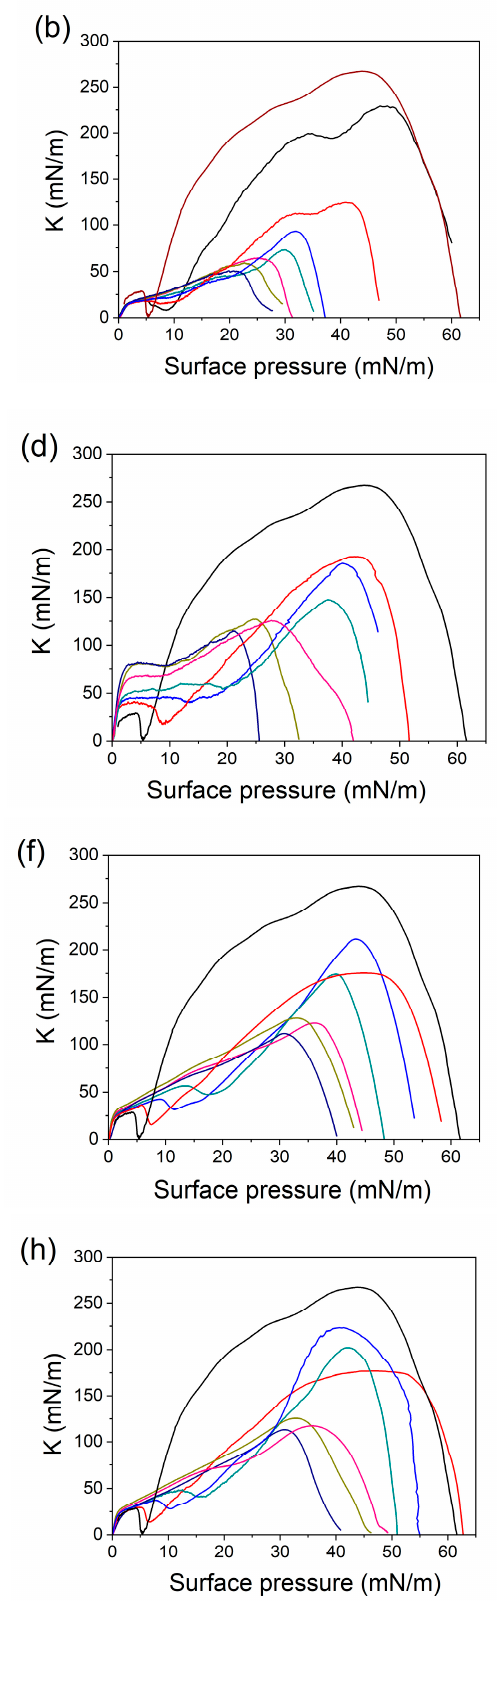
Figure 3. Surface pressure–mean molecular area ( π -A) ( a , c , e , g , i ) and compressibility (K- π ) ( b , d , f , h , j ) isotherms for mixture of DPPC and: ( a , b ) Toc; ( c , d ) CT; ( e , f ) OT; ( g , h ) MT; ( i , j ) ST. Molecular fraction (MF) of components is given in the legend. All π -A and K- π isotherms for different MF of Toc were obtained at pH 3. All presented plots for CT and investigated esters were collected at pH 7. The π -A isotherms of mixed DPPC/Toc monolayers at pH 3 at different Toc molar fractions are shown in Figure 3a. The A 1 parameter slowly changes with Toc concentra- tion. At surface pressure below 7 mN/m, the increasing presence of Toc leads to contrac- tion of isotherms, whereas, above that pressure, an expansion of isotherms occurs. Simul- taneously, increasing molar ratio of Toc leads to lowering of π c of such mixtures. The ex- pansion shapes of isotherms for 50 and 70 mol% of Toc differ compared to those at lower concentrations; however, they show close π c values. The isotherm for 70 mol% displays a very similar shape as that for pure Toc, thus reflecting the dominant presence of Toc in the sample. Elevated π c compared to pure Toc suggests interaction between components.